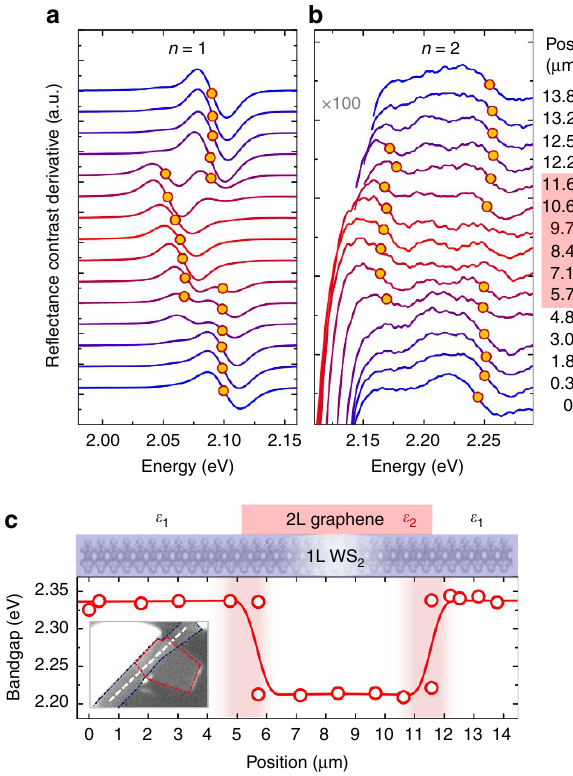
Figure 4 | In-plane heterostructure via Coulomb engineering of monolayer WS 2 . ( a ) First-order derivatives of the reflectance contrast of a 1L WS 2 sample for varying spatial positions across the lateral 1L WS 2 /2L graphene boundary. The data are shown in the spectral range of the exciton ground state ( n ¼ 1) resonance and vertically offset for clarity. ( b ) For the spectral range of the excited state ( n ¼ 2) of the exciton with the vertical axis scaled by factor of 100 for direct comparison. Full circles in a , b indicate peak energies of the resonances, corresponding to the points of inflection of the derivatives. ( c ) Spatially dependent bandgap energy extracted from the exciton peak positions along the profile of the lateral WS 2 /graphene heterostructure, as illustrated in the schematic representation and marked by the dashed line in the optical micrograph. The shaded areas indicate the diffraction limit corresponding to the spatial resolution of our measurement and the solid line is a guide to the eye. The spatial dependence is presented in Fig. 4c along the path marked in the optical micrograph (inset), which includes two WS 2 /graphene in-plane junctions. As previously discussed, the induced energy shifts result in an overall decrease of the relative energy separation D 12 from about 160 meV, down to 105 meV. Here, the binding energy is extracted by multiplying D 12 with the scaling factor deduced from the QEH calculations presented in Fig. 2 (1.54 and 1.40 for the bare and 2L graphene-covered sample, respectively) to obtain the bandgap at each point. The resulting bandgap profile is representative of a potential well (graphene-covered area) surrounded by two adjacent barriers at higher energies (bare sample). Model self-energy calculations on monolayer TMDCs in structured dielectric environments 34 suggest that the interface between the uncapped and capped regions should yield an in-plane type-II heterostructure. In particular, the areas capped by graphene are expected to have a higher local valence band that acts as a potential well for holes. The dielectric effect on the conduction band is predicted to be weaker, with a slightly higher energy for the capped regions leading to a small barrier for electron flow from the bare to